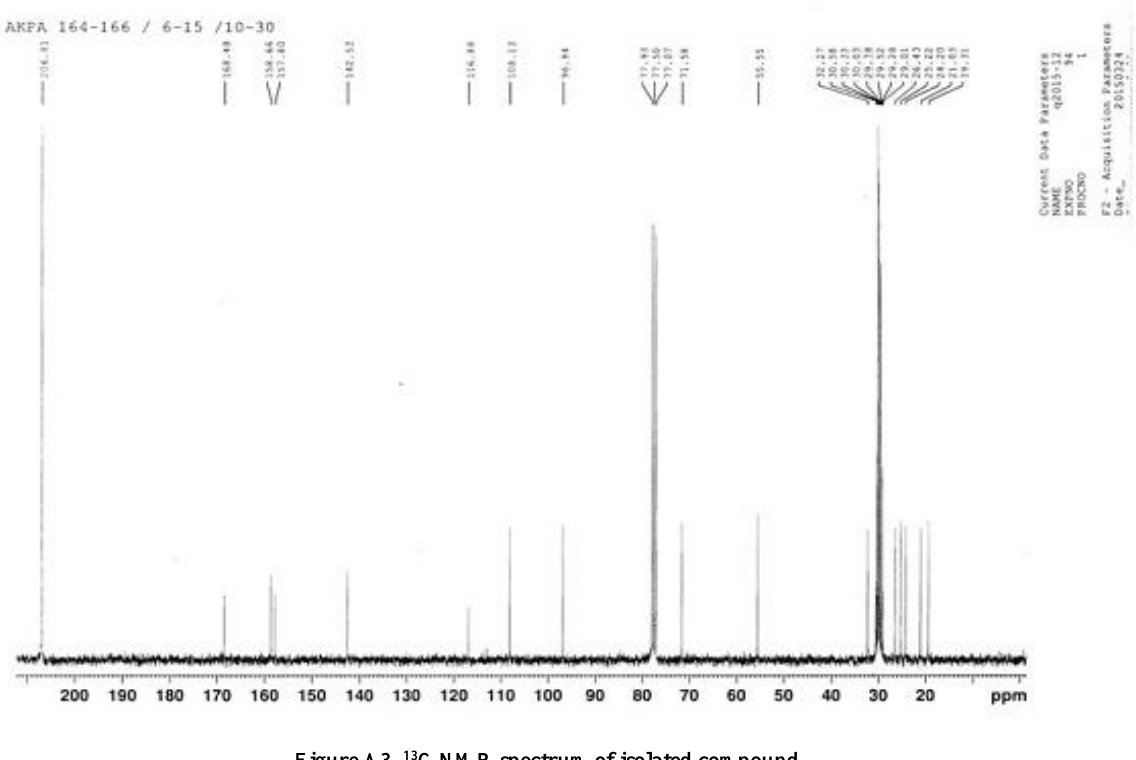
Figure A3. 13 C NMR spectrum of isolated compound